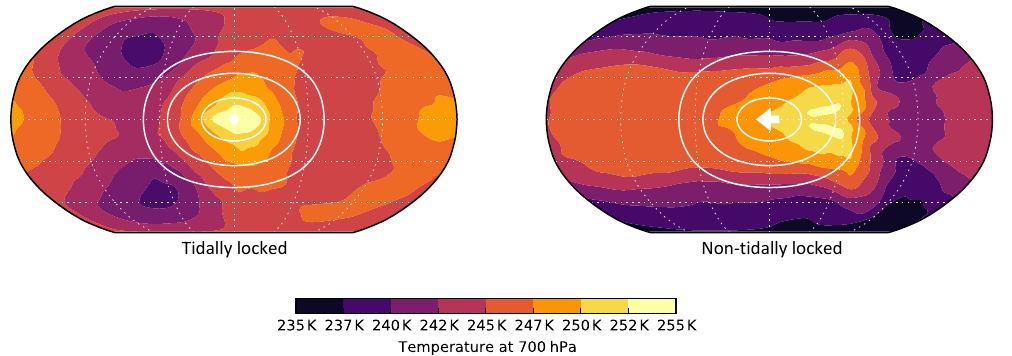
Figure 10. Experiments comparing the atmospheric dynamics on tidally locked and non-tidally locked exoplanets, using a primitive equation model with forcing via thermal relaxation to a specified field. Filled colour contours show the temperature at 700hPa and white contours show the location of the forcing. For the non-tidally locked case the substellar point is shown with a small white arrow denoting is direction of passage, which is to the left, here with a velocity of 25ms − 1 .